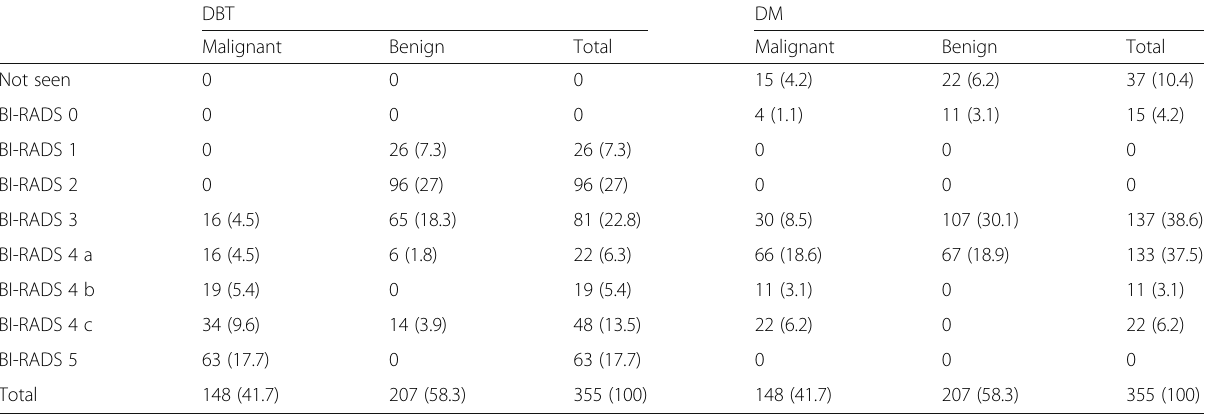
Table 3 BI-RADS categories of the 355 breast lesions detected on DBT and DM in relation to the final